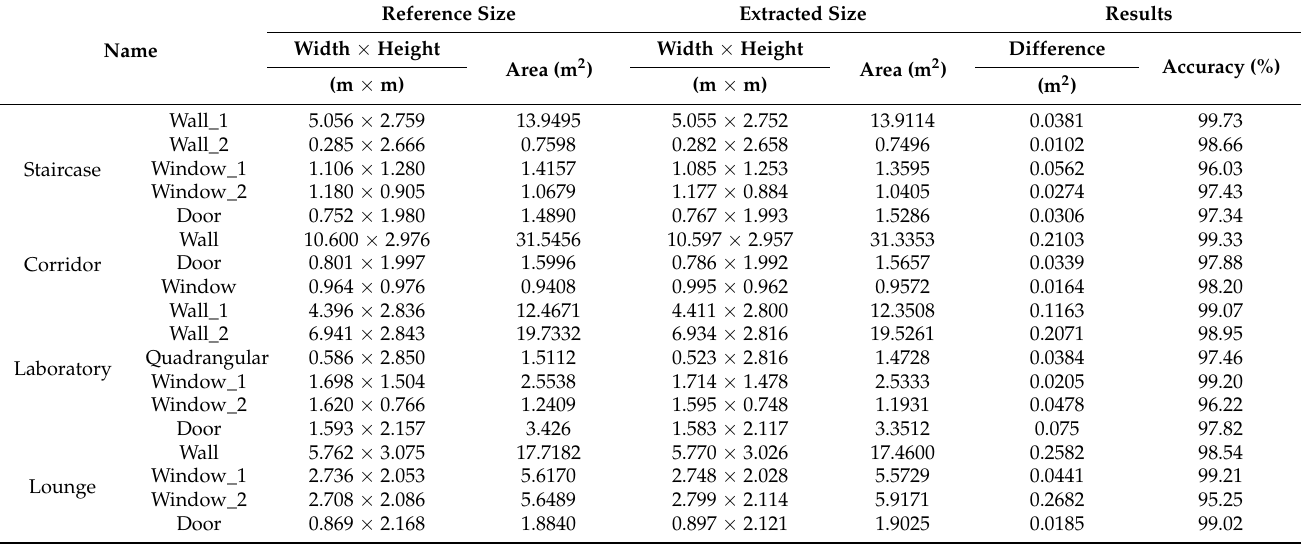
Table 2. Dimensional calculation results of partially major structures in four indoor